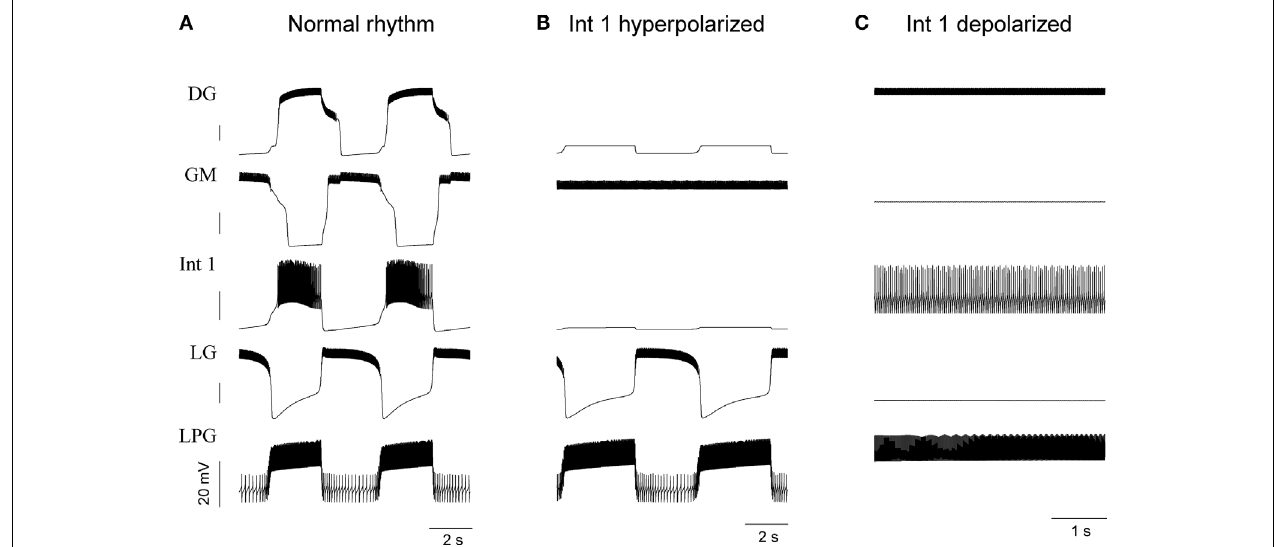
FIGURE 12 | The computational model of the gastric circuit nicely reproduces the voltage output of the neurons. The normal regular burst oscillation appears on the left panels (A) . Hyperpolarizing Int 1 below fi ring threshold removes the rhythm in the medial tooth neurons but the LG and LPG neurons keep